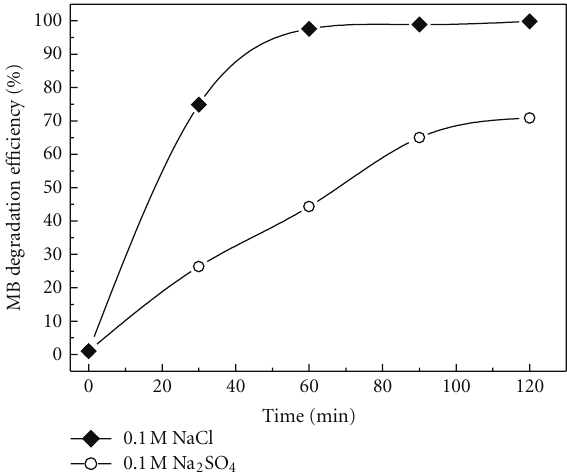
Figure 8: The comparison of degradation e ffi ciency via PEC route in 0.1 MNaCl and Na 2 SO 4 , bias at